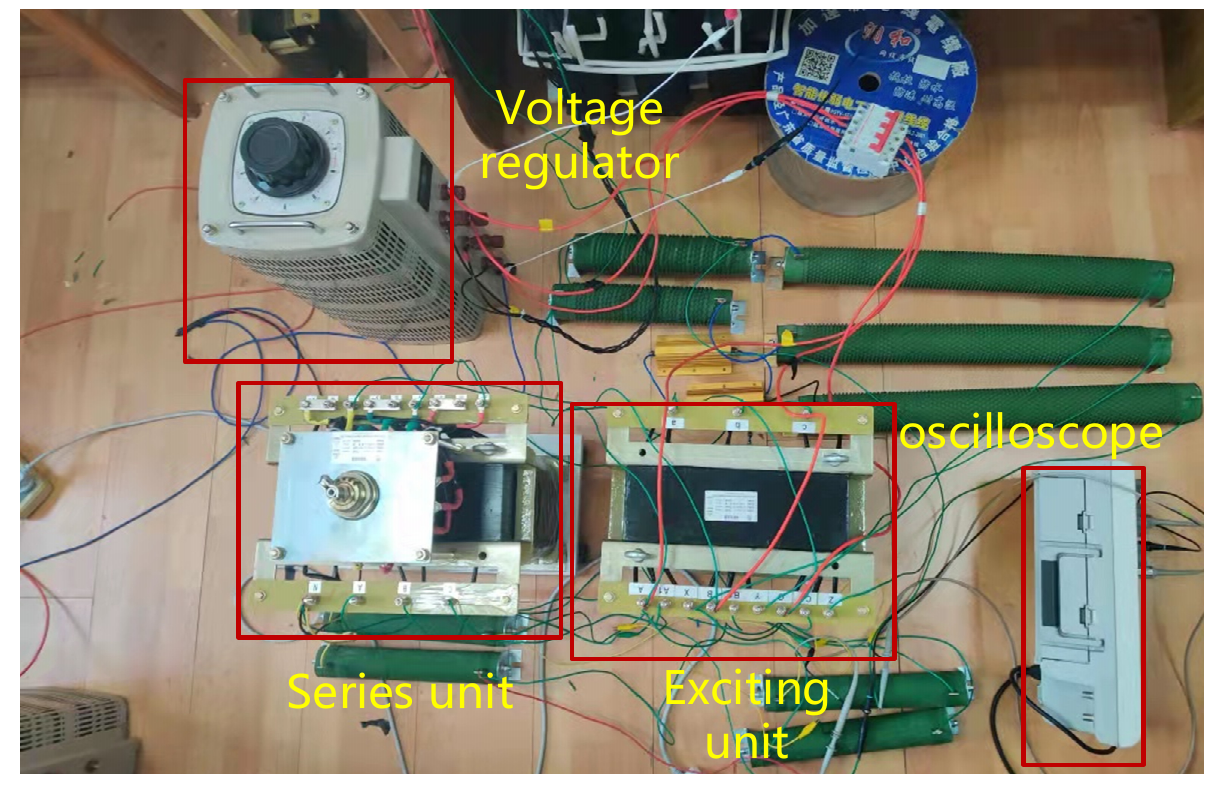
Figure 18. Experimental schematic diagram .